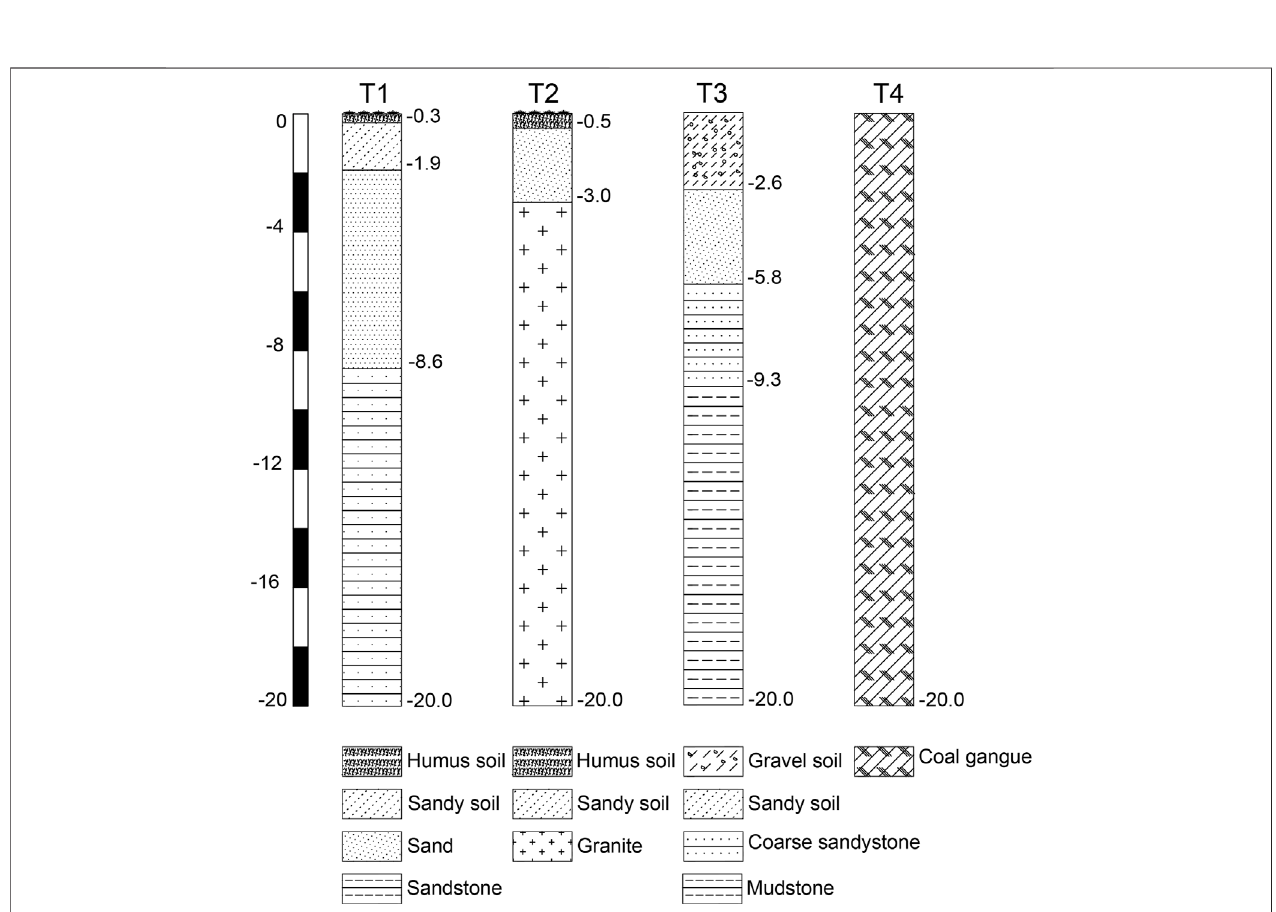
FIGURE 2 | Lithology at the four monitoring boreholes in the back fi lled and undisturbed areas in the Gulianhe strip coalmine in the Hola Basin in northern Da Xing ’ anling Mountains in Northeast China.